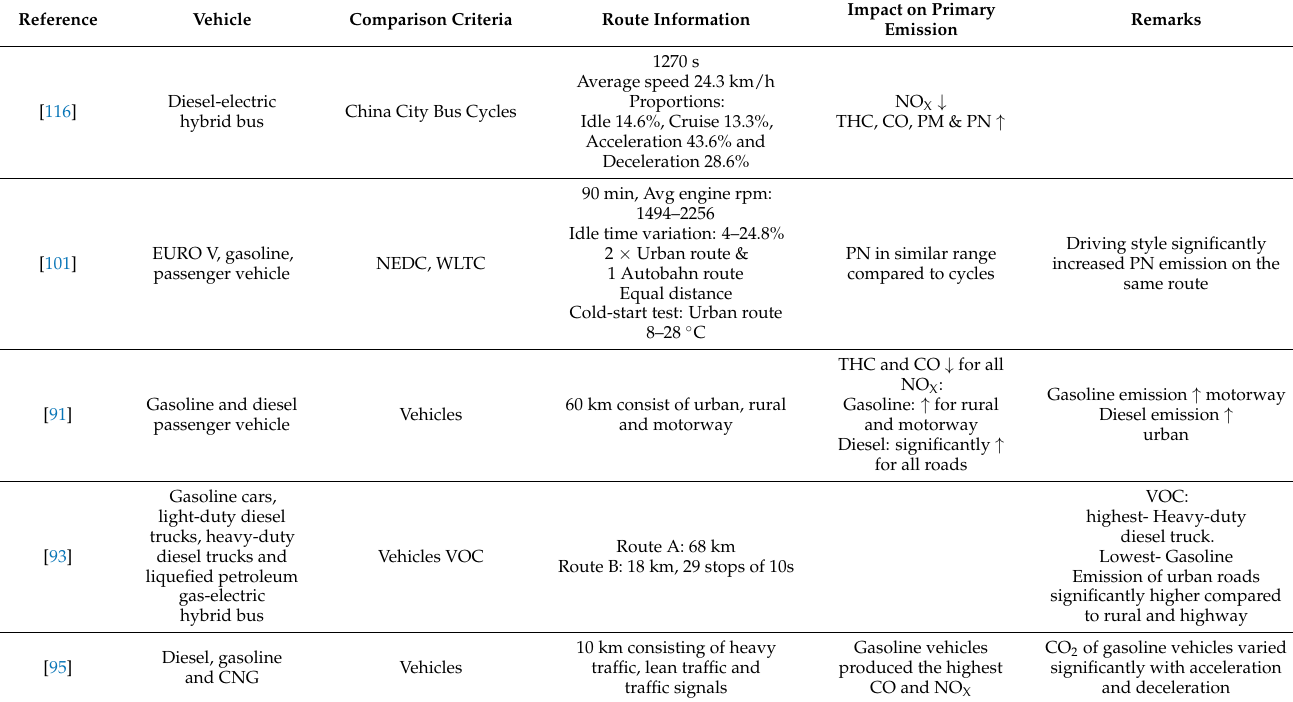
Table 6. Summary of RDE